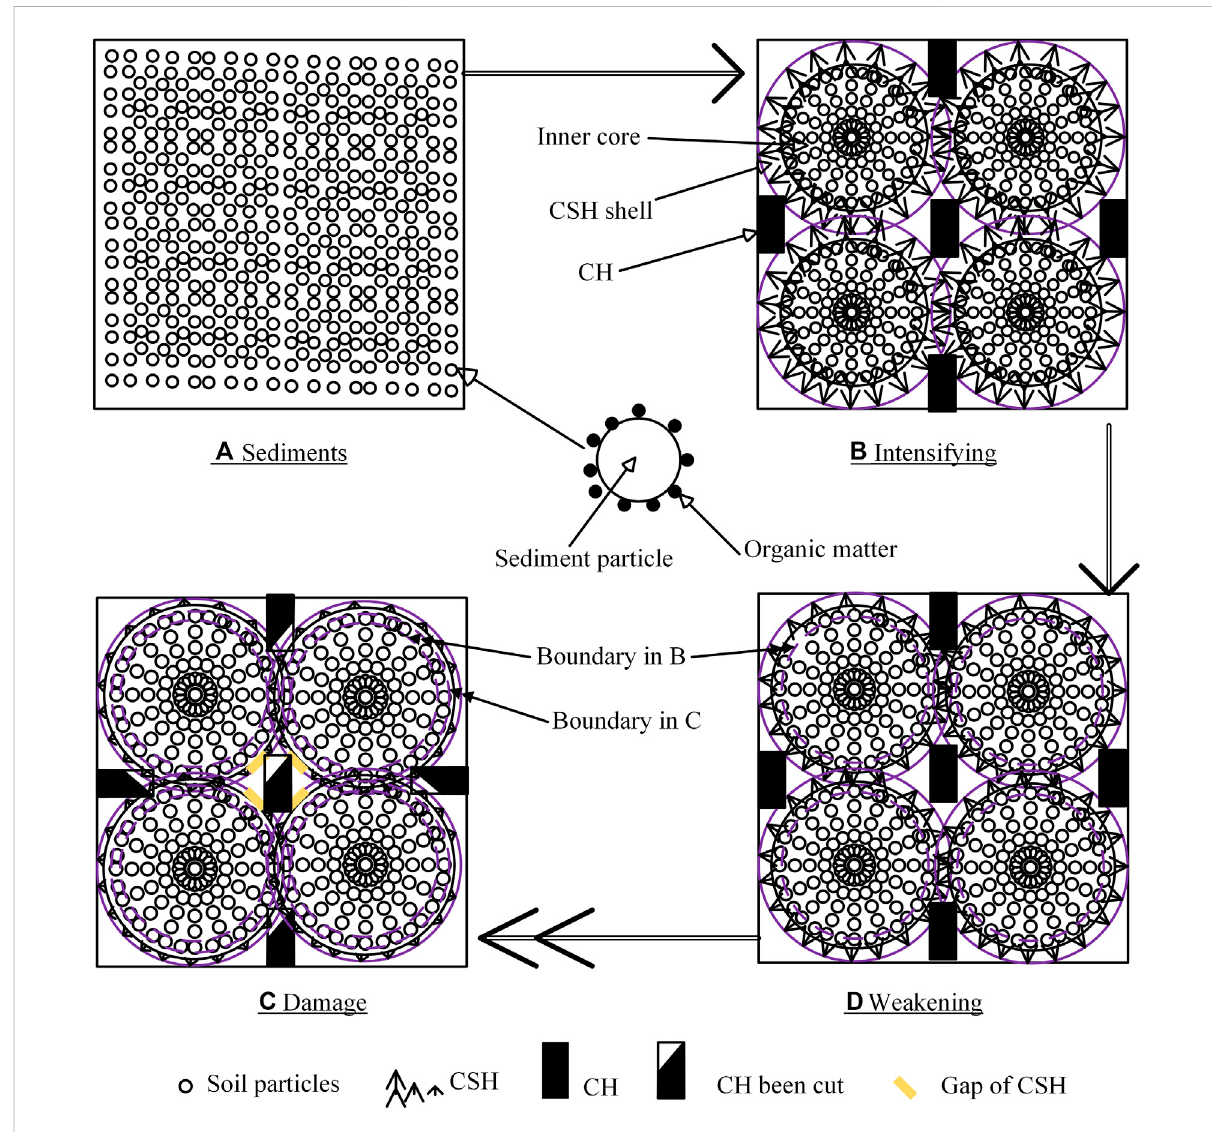
FIGURE 10 Microstructure evolution of S/S sediments: (A) sediments, (B) intensifying, (C) weakening, and (D) damage.